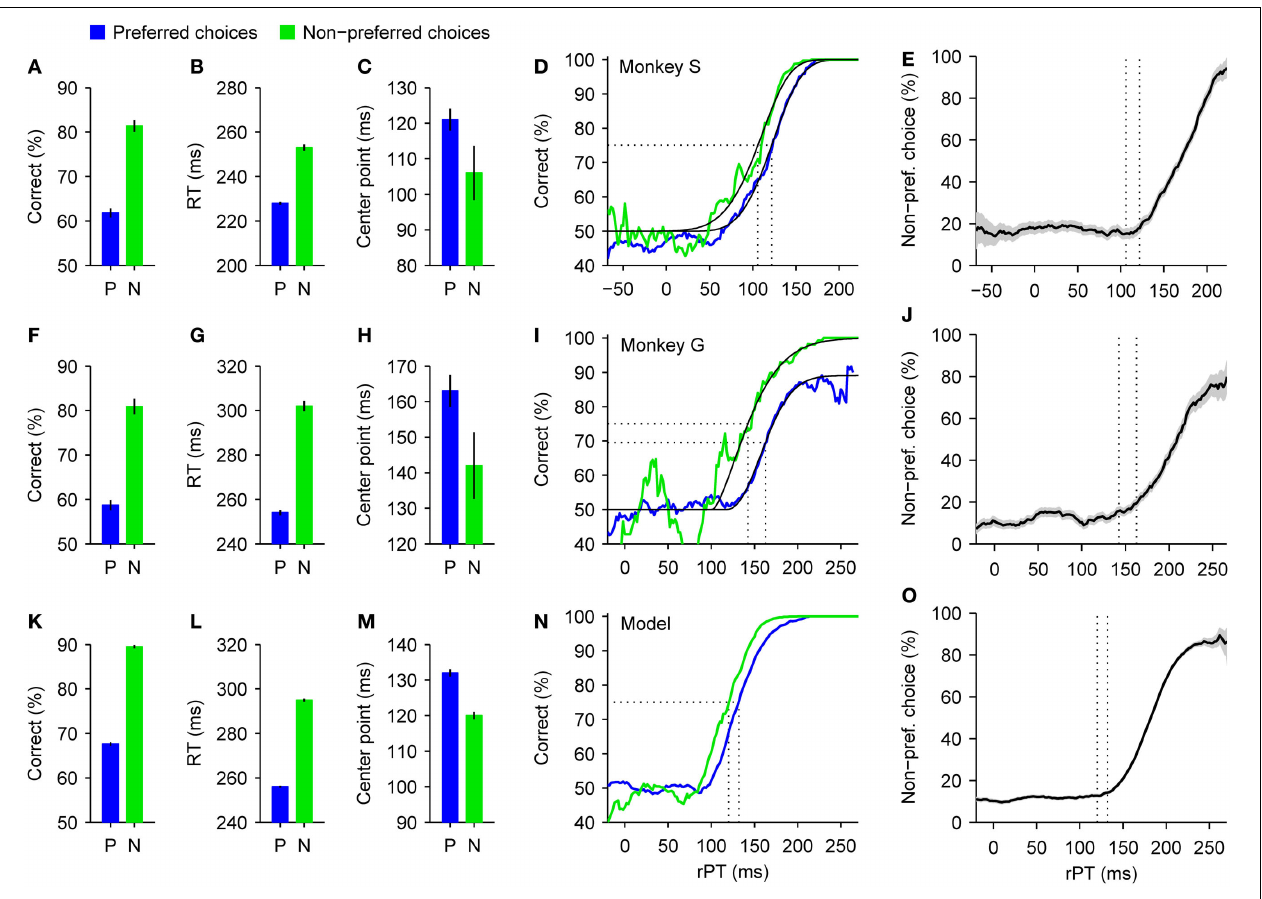
FIGURE 6 | Psychophysical performance in a spatial bias experiment. Correct choices to one side yielded a higher reward than correct choices to the other side. Data are shown sorted according to the subject’s choices, either to the preferred (high-reward, blue) or the non-preferred (low-reward, green) side, as indicated. (A–C) Summary statistics for monkey S. When the preferred ratherthanthenon-preferred sidewaschosen, theoverallsuccessrate (A) and meanRT (B) decreasedsubstantially,andthetachometriccurveshiftedslightly totheright (C) .Errorbarsindicate ± 1SE. (D) Tachometriccurvesfrommonkey S. Fitted Weibull functions (black curves) are shown together with the